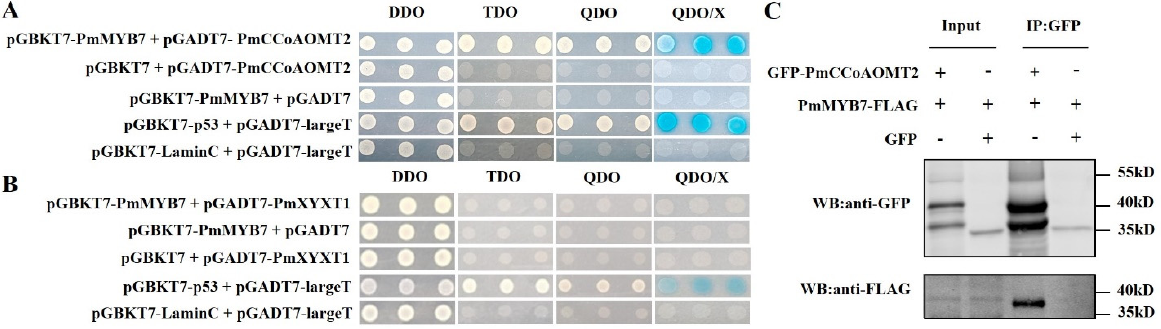
Figure 7. Validation of the interaction proteins. ( A ) Point-to-point validation of the interaction of pGBKT7-PmMYB7 + pGADT7-PmCCoAOMT2. pGBKT7-p53 + pGADT7-largeT was cotransformed as a positive control, and pGBKT7-laminC + pGADT7-largeT was cotransformed as a negative control. ( B ) Point-to-point validation of the interaction of pGBKT7-PmMYB7 + pGADT7-PmXYXT1. ( C ) Detection of PmMYB7 protein and PmCCoAOMT2 protein interactions in N. benthamiana leaves by Co-IP.